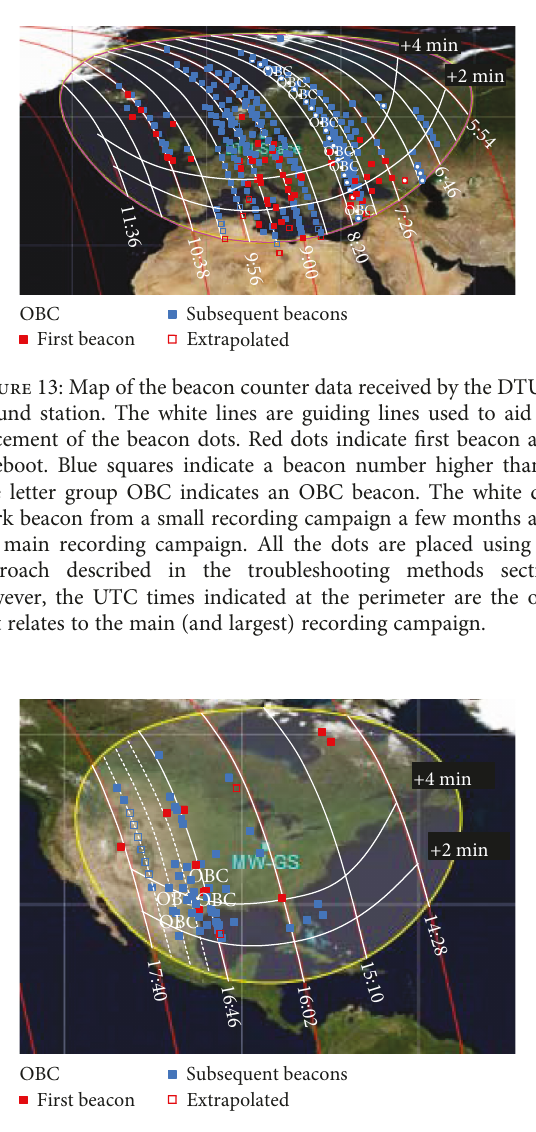
Figure 14: Map of the beacon counter data received by Michael Williams, K9QHO, ground station in Indiana, USA. White lines are guide lines to aid the placement of beacon dots. Red squares indicate fi rst beacon after a reboot. Blue squares indicate a beacon number higher than 1. The letter group OBC indicates an OBC beacon.